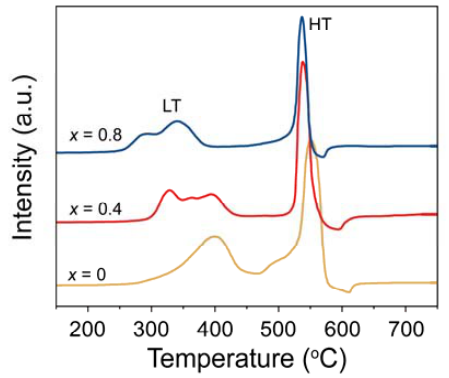
Figure 4. TPR of fresh oxygen carriers.